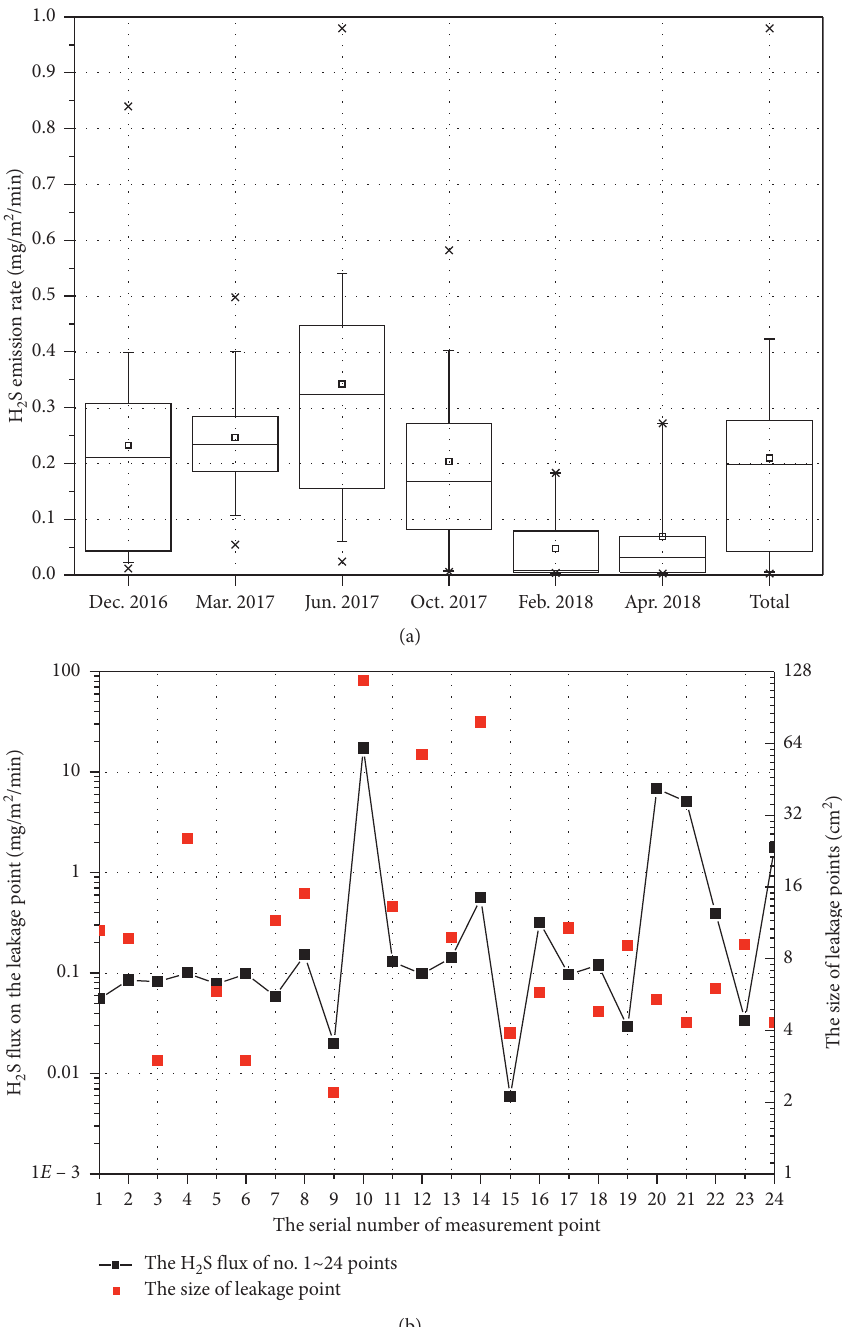
Figure 4: H 2 S emission rates in different covers. (a) H 2 S emission rates on the working area. (b) H 2 S emission rates on the leakage